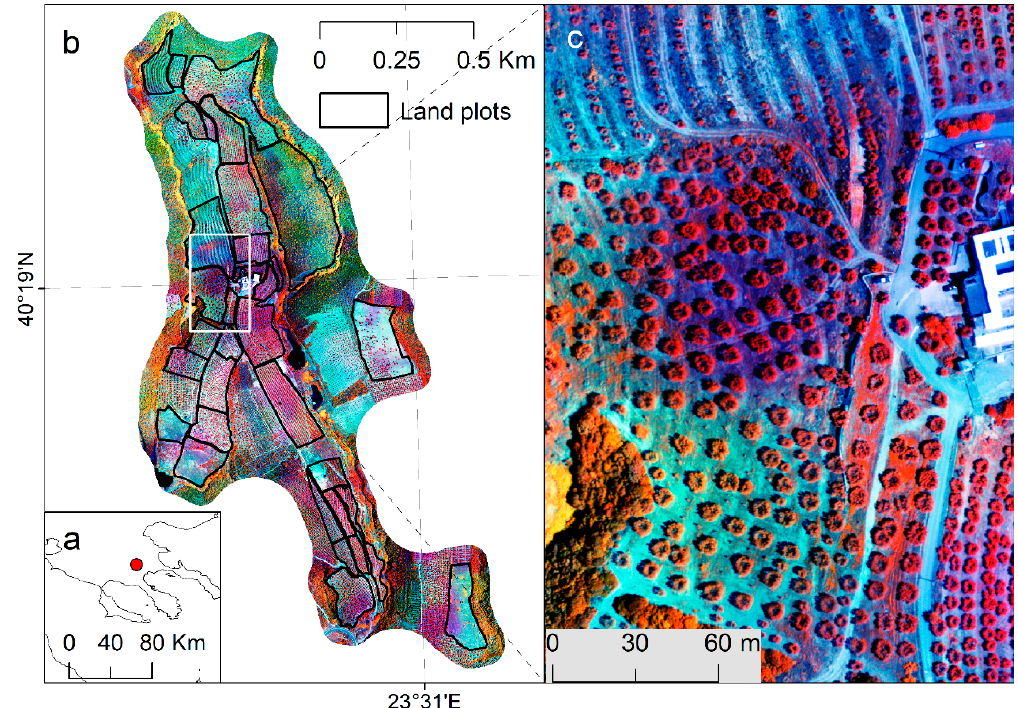
Figure 1. Imaging of the olive plantation under study: ( a ) the location of the study site in Chalkidiki, Greece; ( b ) the imaged extent after masking; ( c ) a close view of a false-colour image composite.